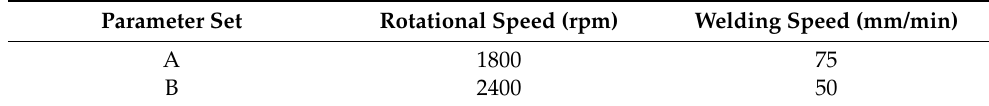
Table 3. Different parameters used for the friction stir welding.